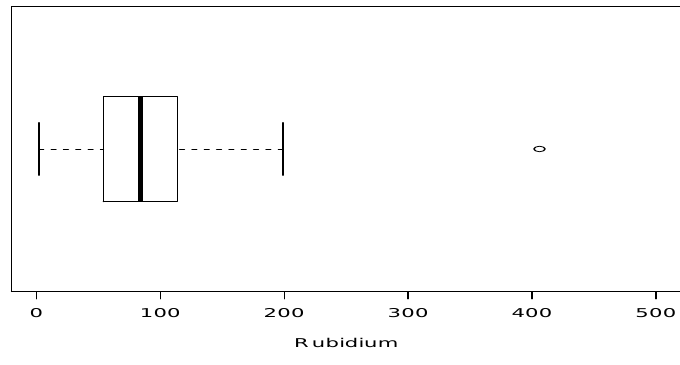
Figure 3. Boxplot for rubidium dataset.